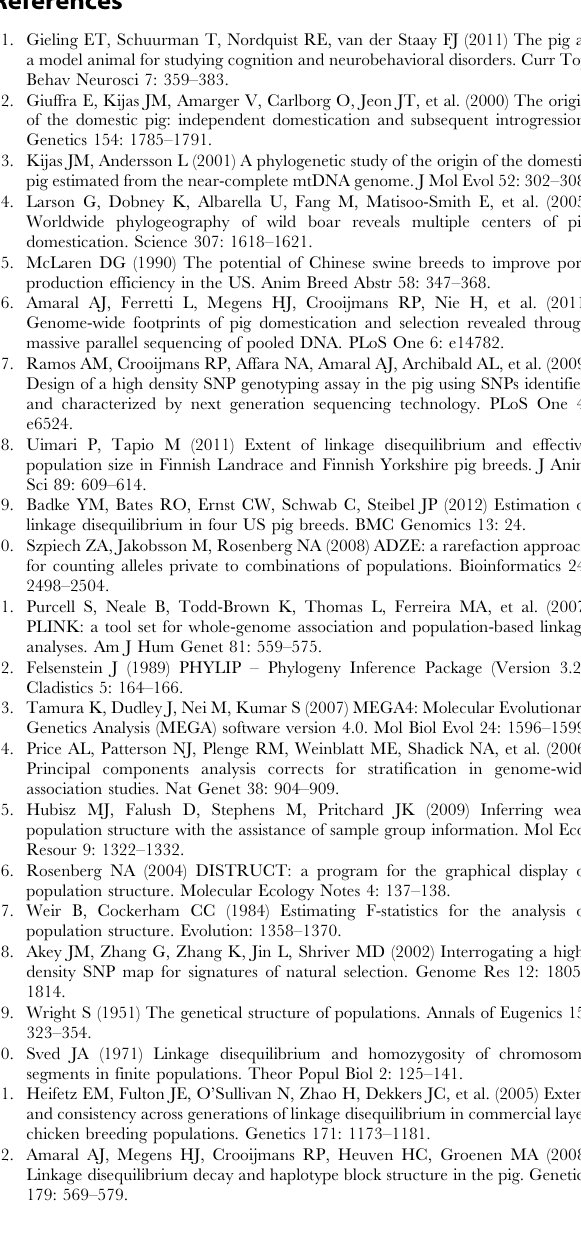
Table S3 SNP outliers and candidate genes under selection identified by BAYESCAN in the contrast of plateau (Tibetan) pigs vs. non-plateau pigs. Table S4 SNP outliers and candidate genes under selection identified by BAYESCAN in the contrast of belted pigs vs. non-belted